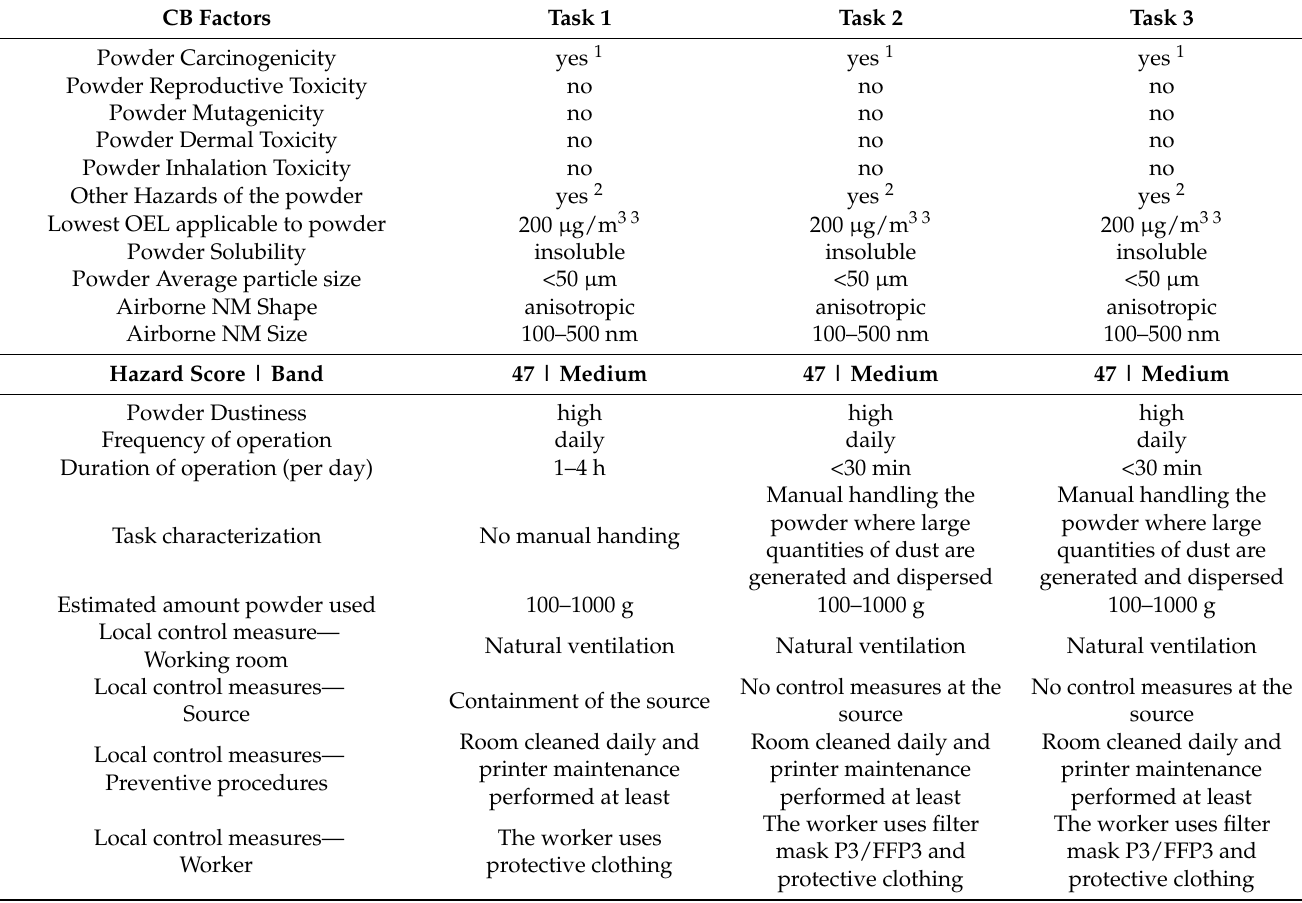
Table 10. Results of the application of the IN